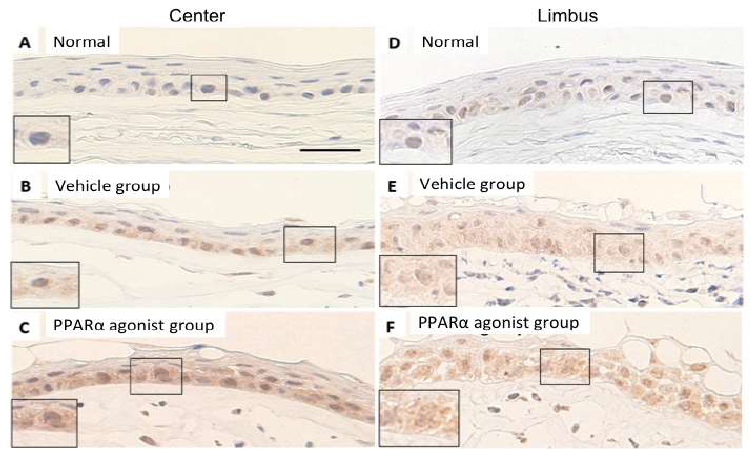
Figure 8. The localization of IκB-α in normal cornea and in alkali-burned cornea in the vehicle and PPARα agonist groups at day 1. Immunohistochemical localization of IκB-α in normal cornea of center ( A ) and limbus ( D ) showed the only a weak labeling in the cytoplasm in the epithelial basement cells. In the alkali-burned cornea of center ( B , C ) and limbus ( E , F ) in the Vehicle ( B , E ) and PPARα agonist ( C , F ) groups, diffuse labeling of the cytoplasm of the epithelial basement cells was observed during re-epithelialization. However, the I κ B- α -positive labeling was stronger in the PPAR α agonist group ( C , F ) compared to these regions of the Vehicle group ( B , E ), suggesting that PPAR α agonist up-regulated I κ B- α in the epithelial basement cells. Scale bar: 20 µ